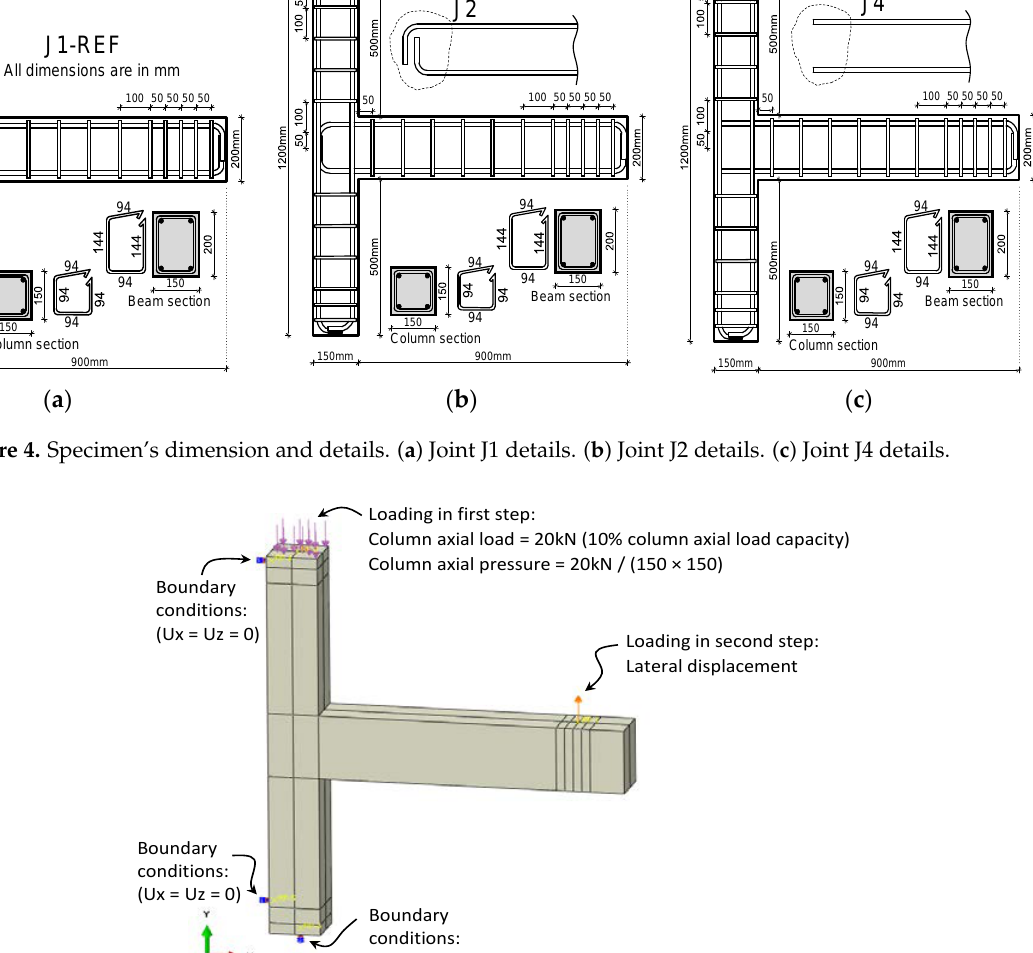
J1-REF All dimensions are in mm